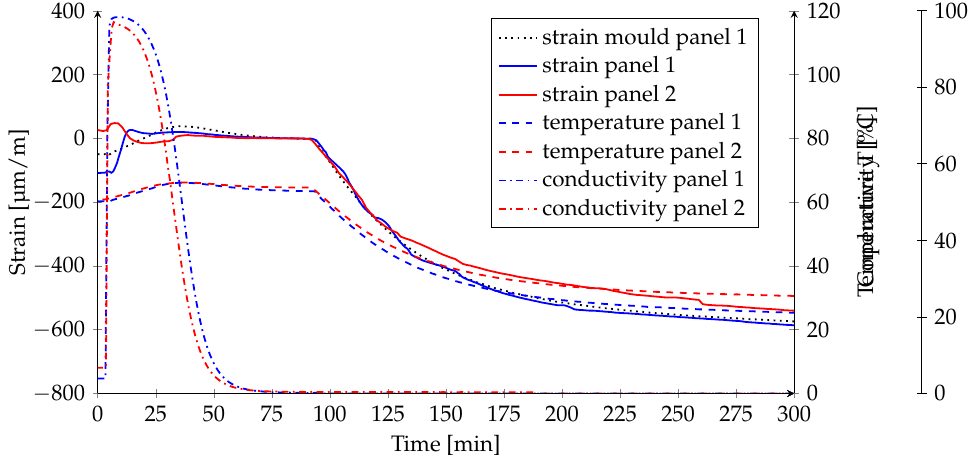
Figure 4. Measured laminate strains, temperatures, conductivities and calculated mould strain of the initial curing step of panel 1 and panel